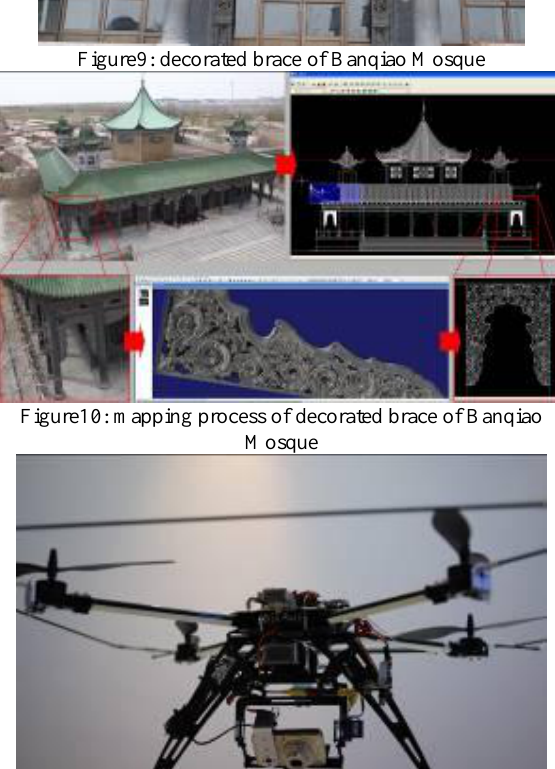
Figure9: decorated brace of Banqiao Mosque